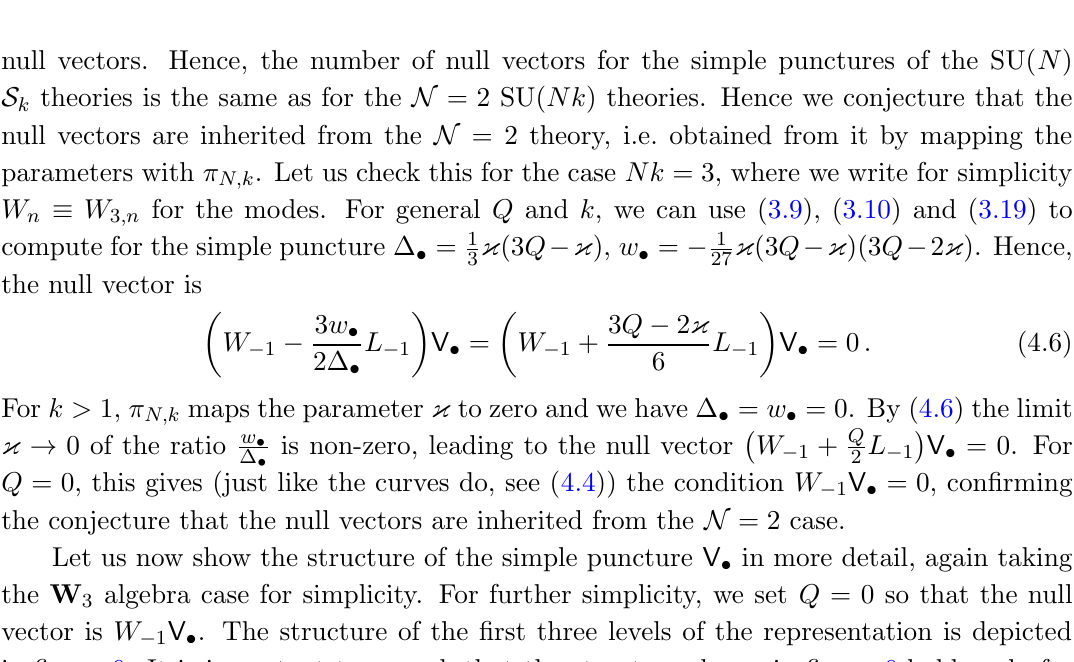
Table 2 . This table contains an overview of the main properties of the punctures for the SU( N ) S k theory for k >